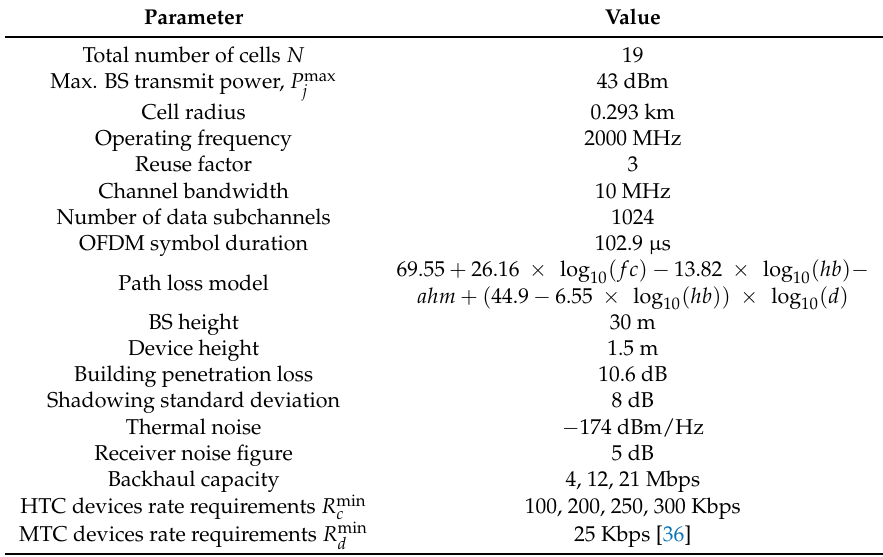
Table 2. Summary of Simulation